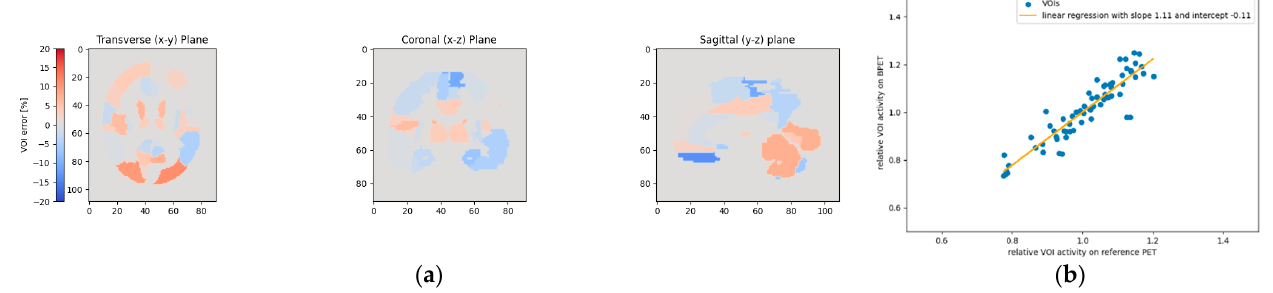
Figure 13. This figure shows the relative VOI deviations when using template T2 for patient P3. By far the highest absolute difference between the BPET image and the reference PET is observed in the lower anterior of the brain (left and right gyrus rectus) ( a ). These two VOIs with the highest deviations can be seen on the linear regression plot ( b ) on the lower right.